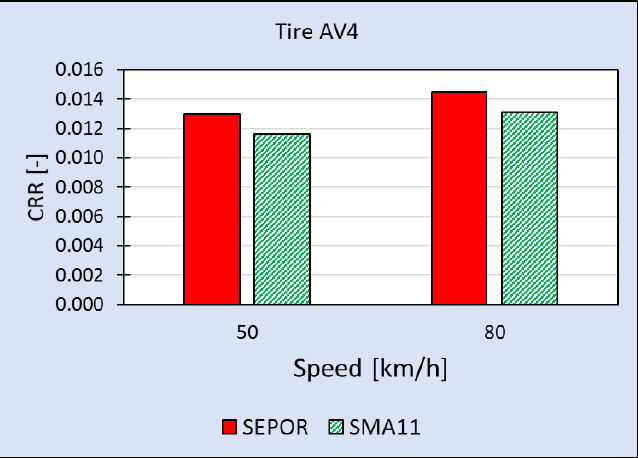
Figure 29. Coefficient of Rolling Resistance for SEPOR-G-PSMA5 W4 and reference pavement SMA11 measured at the Galaktyczna section for tire SRTT at temperature 20 °C.